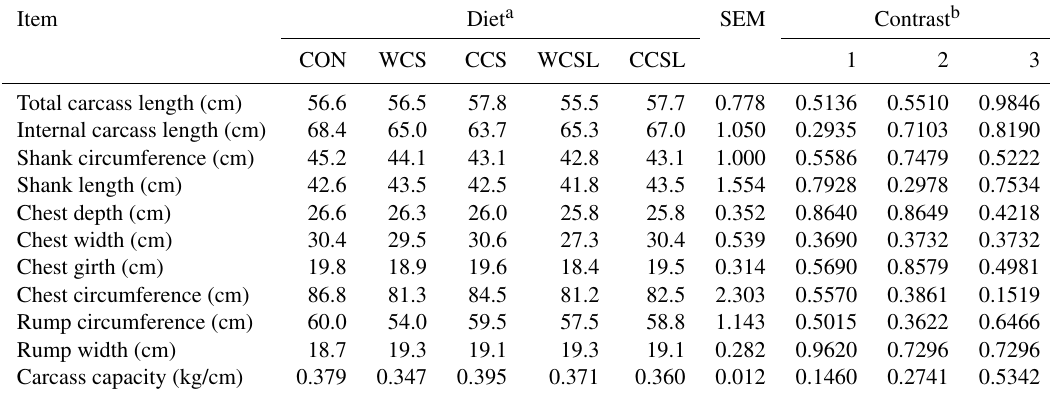
Table 4. Morphometric measurements and quantitative traits of the carcass of Santa Inês cull ewes fed high-concentrate diets with cottonseed associated with calcium